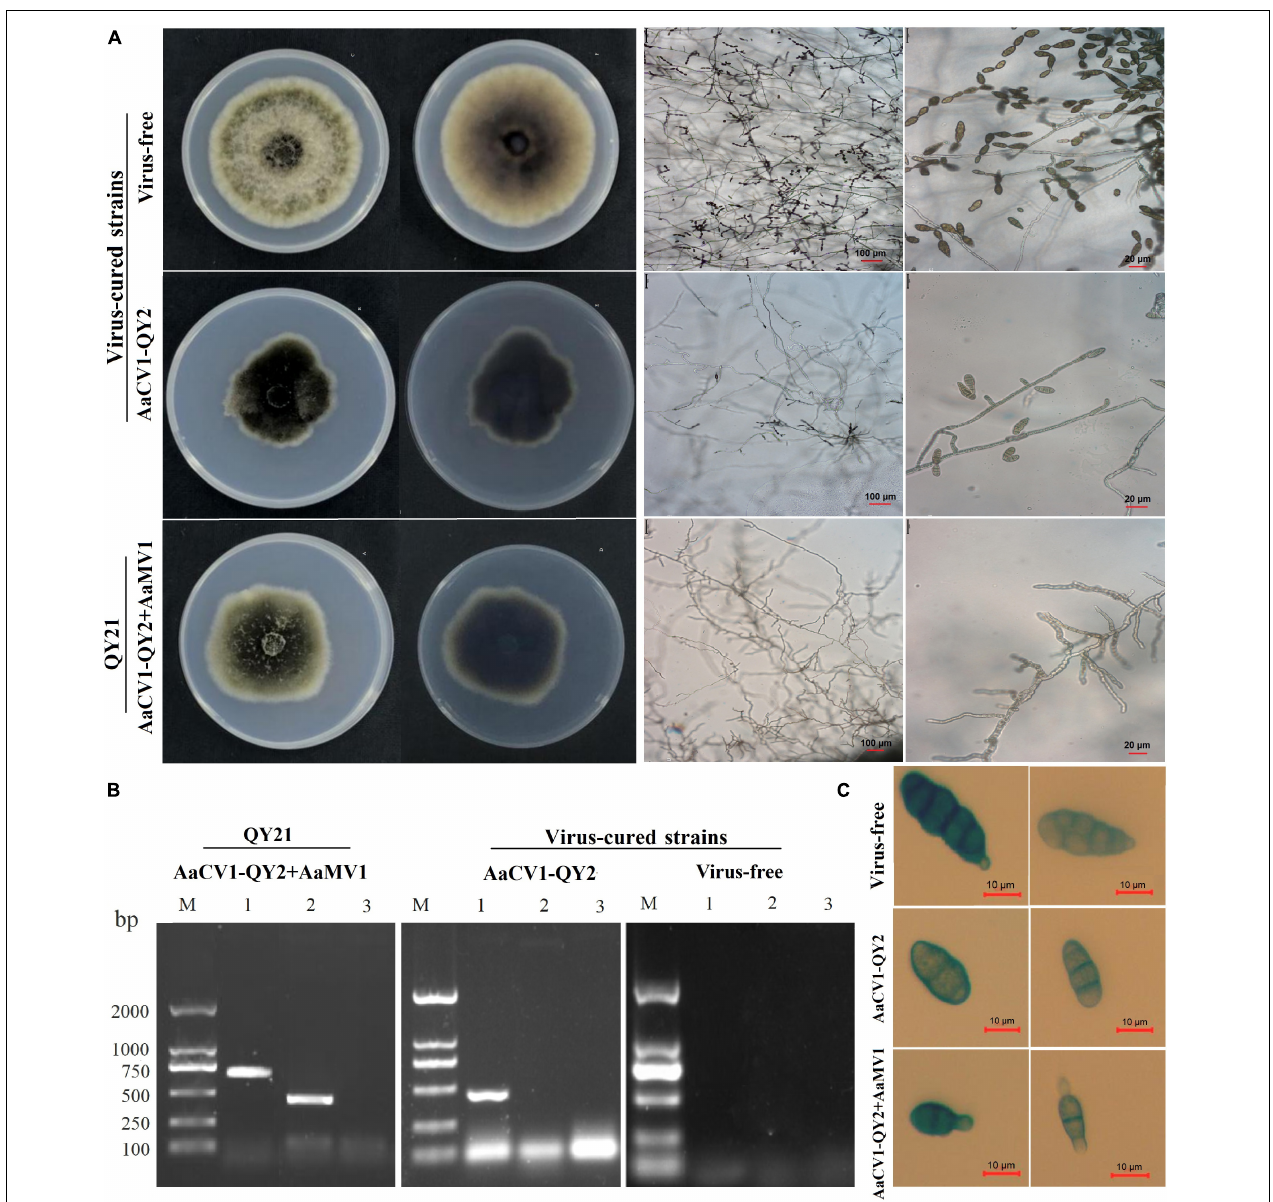
FIGURE 4 | Virus elimination and biological properties of the co-infected and isogenic virus-cured A. alternata strains. The strain QY21 is doubly infected with AaCV1-QY2 and AaMV1; the strain QY21-C1 has eliminated the virus AaMV1 and retains the virus AaCV1-QY2; QY21-C2 strain has completely eliminated all viruses and is virus-free. (A) Colony and mycelial morphology of QY21 and virus-cured strains [potato dextrose agar (PDA), 4 days, 25 ◦ C]. (B) The dsRNA of AaCV1-QY2 and AaMV1 in the co-infected and virus-cured strains was detected by RT-PCR amplification. Lane M is for markers; lanes 1 and 2 show the results of PCR performed with AaCV1-QY2 and AaMV1 specific primers, respectively; lane 9 is for NC. (C) Spore morphology of strains (PDA, 4 days, 25 ◦ C).